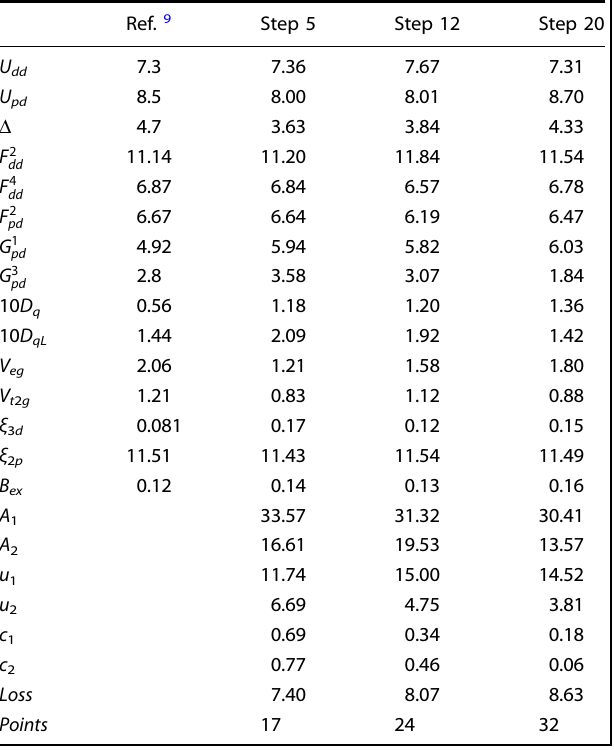
Table 2. The fi tted parameters of the CTM model and arctangent weighted